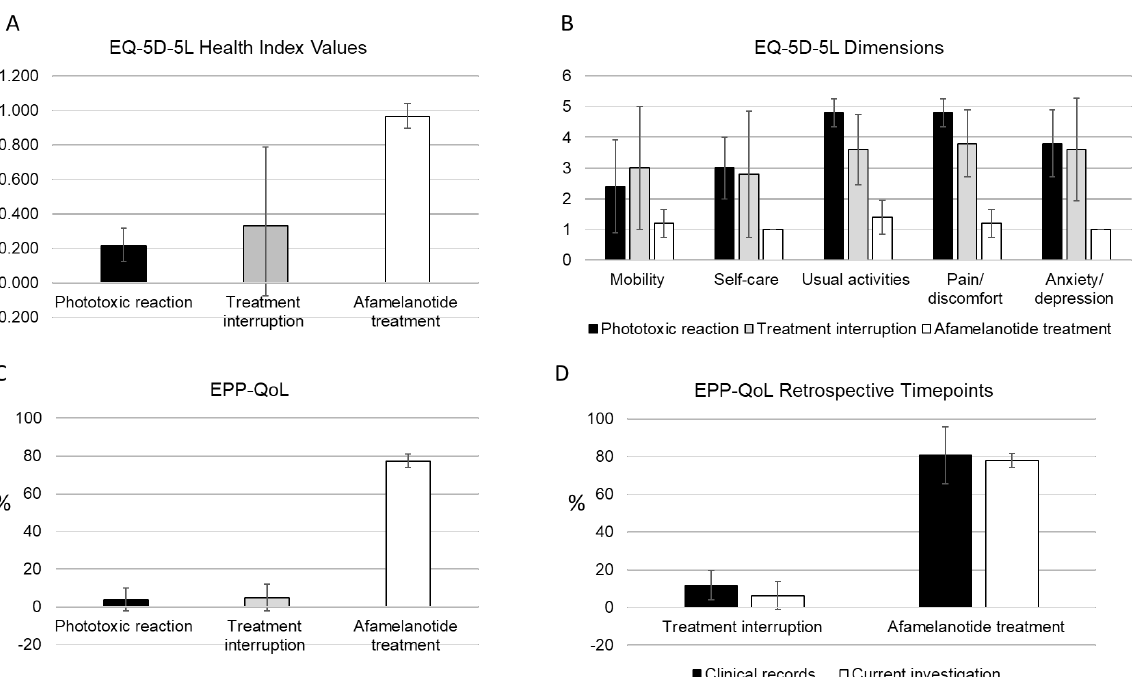
Figure 1. ( A – D ): Results obtained with the EQ-5D and EPP-QoL instruments for patients with erythropoietic protoporphyria.